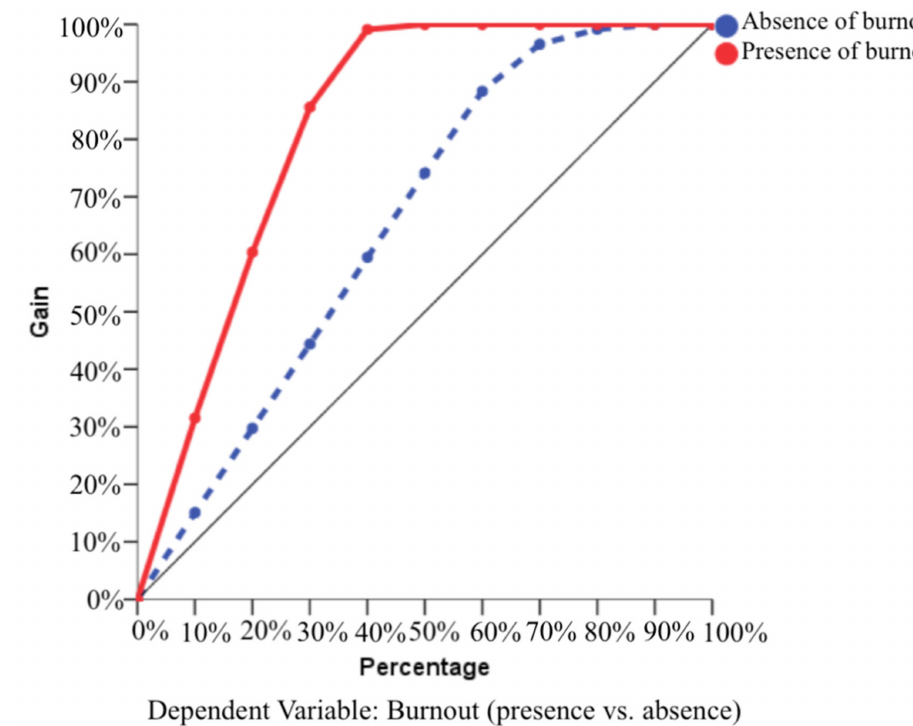
Figure 3. Gain of the artificial neural